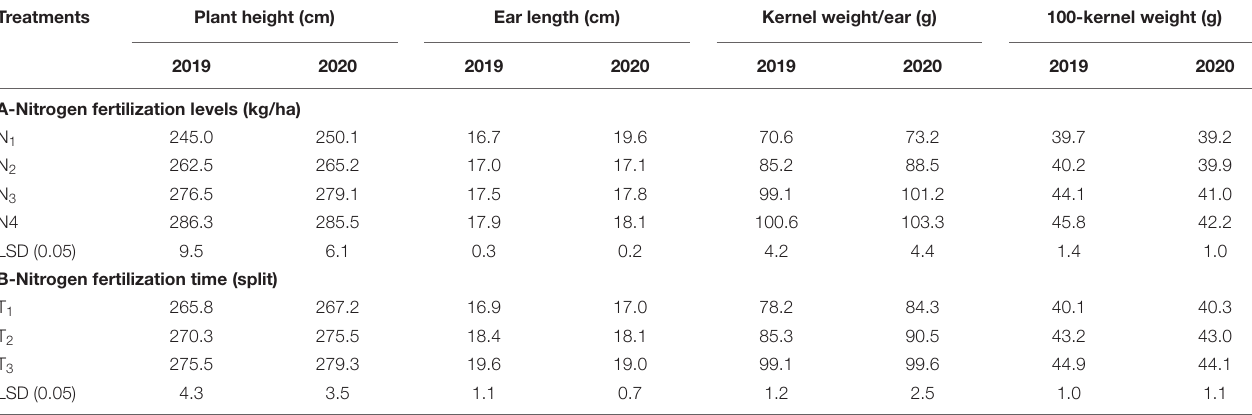
TABLE 5 | Plant attribute of maize ( Zea mays cv. SC. 10) as affected by nitrogen levels and time of application in 2019 and 2020 seasons. Treatments Plant height (cm) Ear length (cm) Kernel weight/ear (g) 100-kernel weight